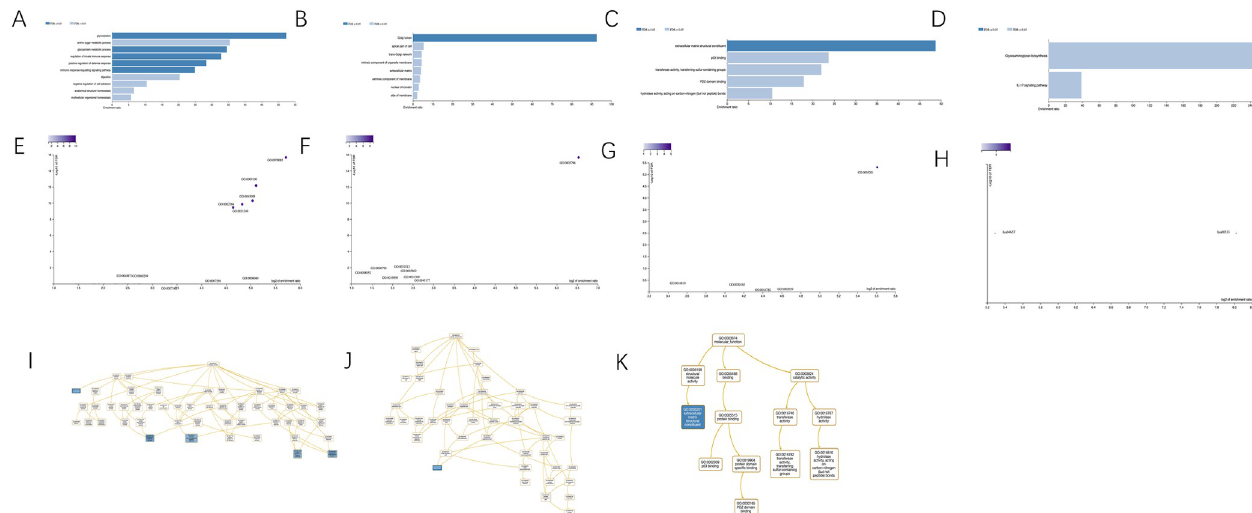
Fig 6. Functional enrichment analysis from the UALCAN. (A) bar chart of BP analysis, (B) bar chart of CC analysis, (C) bar chart of MF analysis, (D) bar chart of KEGG analysis, (E) volcano plot of BP analysis, (F) volcano plot of CC analysis, (G) volcano plot of MF analysis, (H) volcano plot of KEGG analysis, (I) directed acyclic graph of BP analysis, (J) directed acyclic graph of CC analysis, (K) directed acyclic graph of MF analysis.